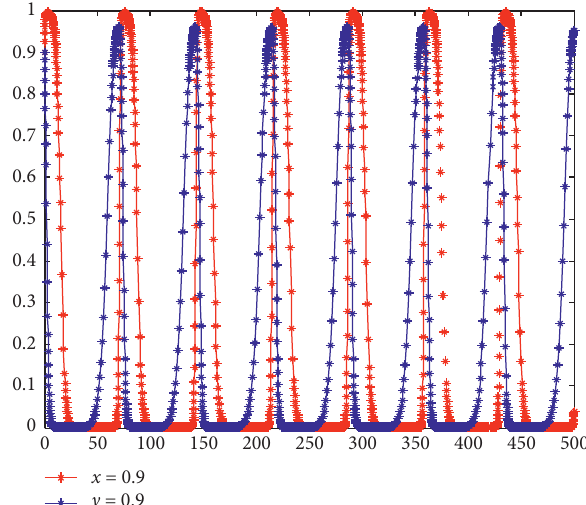
Figure 3: Influence of critical point of government punishment on the formation of green dairy industry chain.